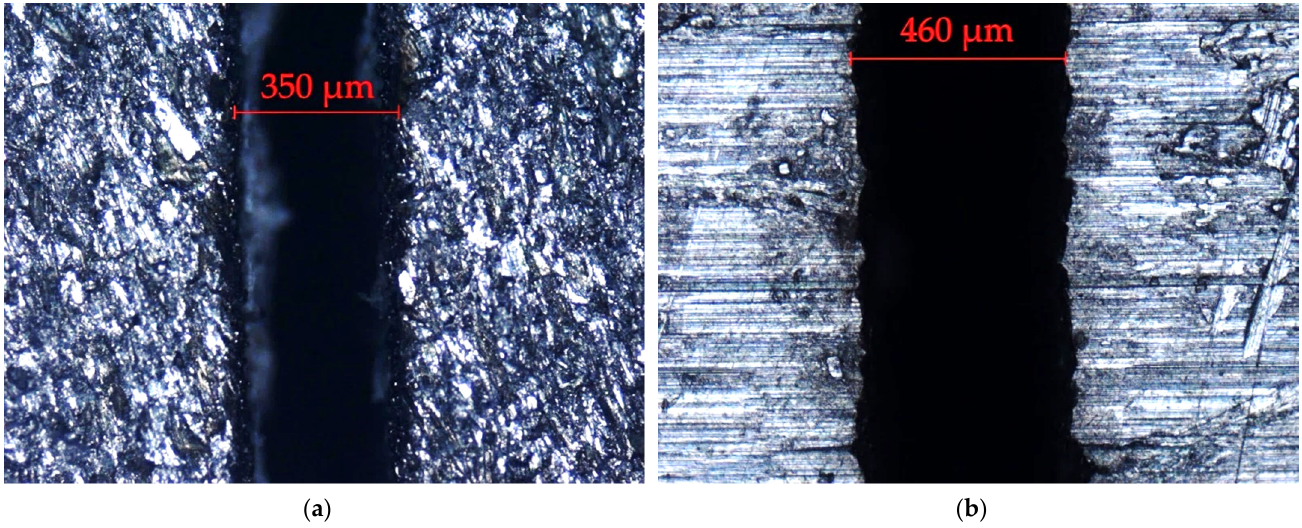
Figure 4. Cut slot (kerf) in the samples after electrical discharge machining with a brass wire tool electrode in deionized water: ( a ) X10CrNiTi18-10 (12kH18N10T) steel, V o = 84 V, I = 2.0 A, D = 1.5 µs, f = 30 kHz, R w = 5.0 m/min, F t = 0.25 kg, R f = 0.1 mm/min; ( b ) 2024 (D16) duralumin, V o = 108 V, I = 0.8 A, D = 1.0 µs, f = 10 kHz, R w = 6.0 m/min, F t = 0.25 kg, R f = 0.1 mm/min.